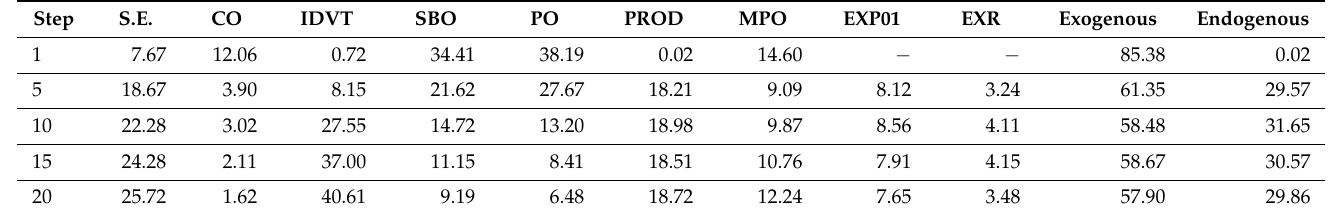
Table 10. Outcomes of the Forecast Error Variance Decomposition on MPO.